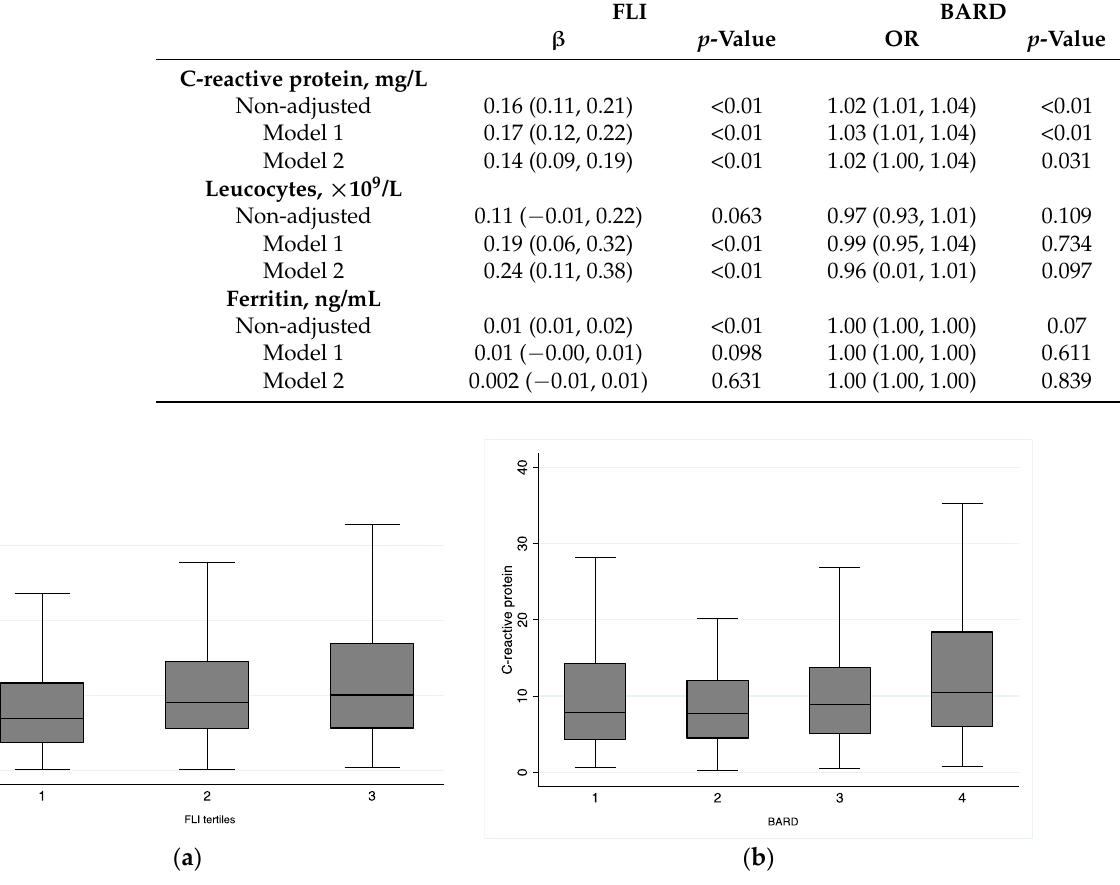
Figure 1. Boxplot displaying C-reactive protein levels (mg/L) according to FLI tertiles ( a ) and BARD ( b ) categories. Abbreviations: FLI, Fatty Liver Index; BARD, BMI, AST/ALT ratio, and presence of diabetes. FLI tertile 1 = 7.41 to 95.56; FLI tertile 2 = 95.56 to 98.68; FLI tertile = 98.68 to 100.